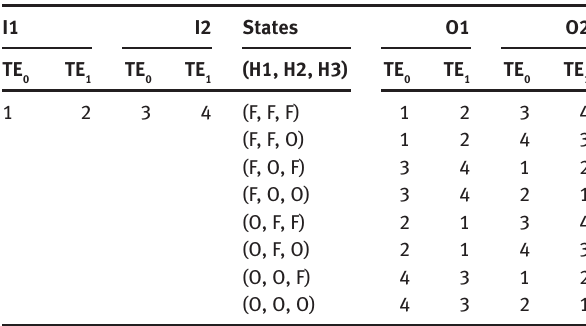
Table 1: Complete set of routing states of proposed multimode switch.